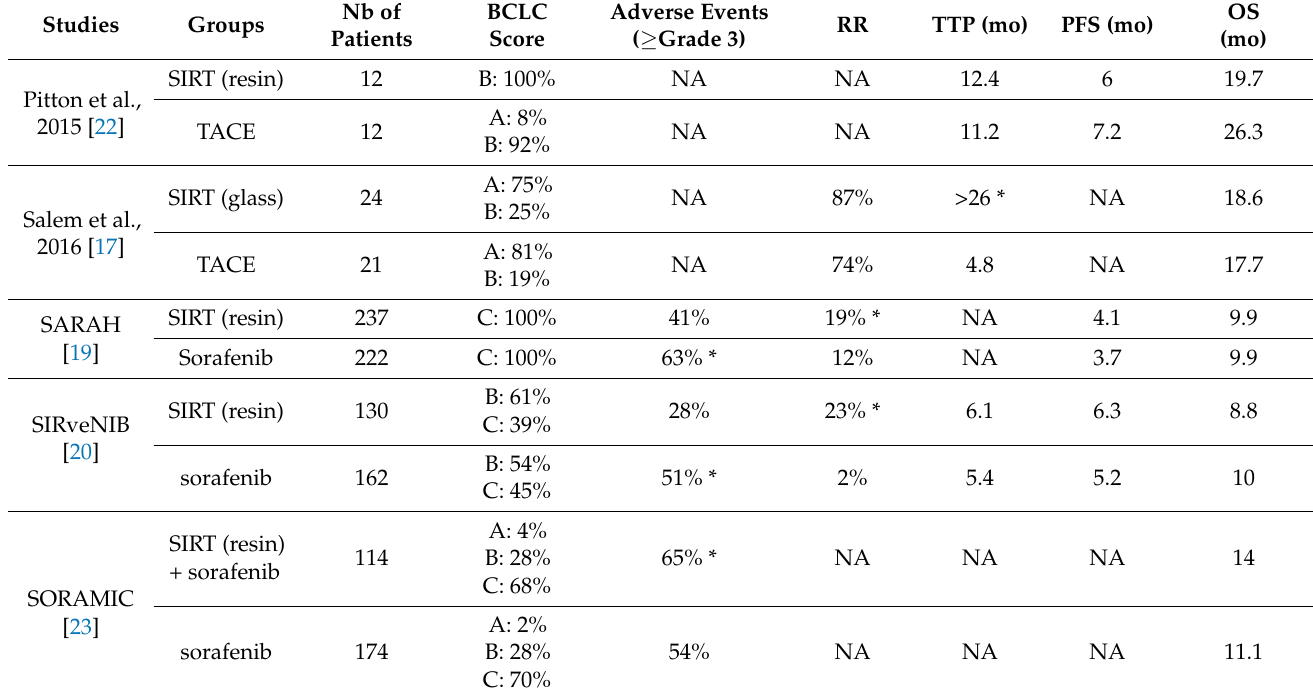
Table 1. Prospective and randomized studies in hepatocellular